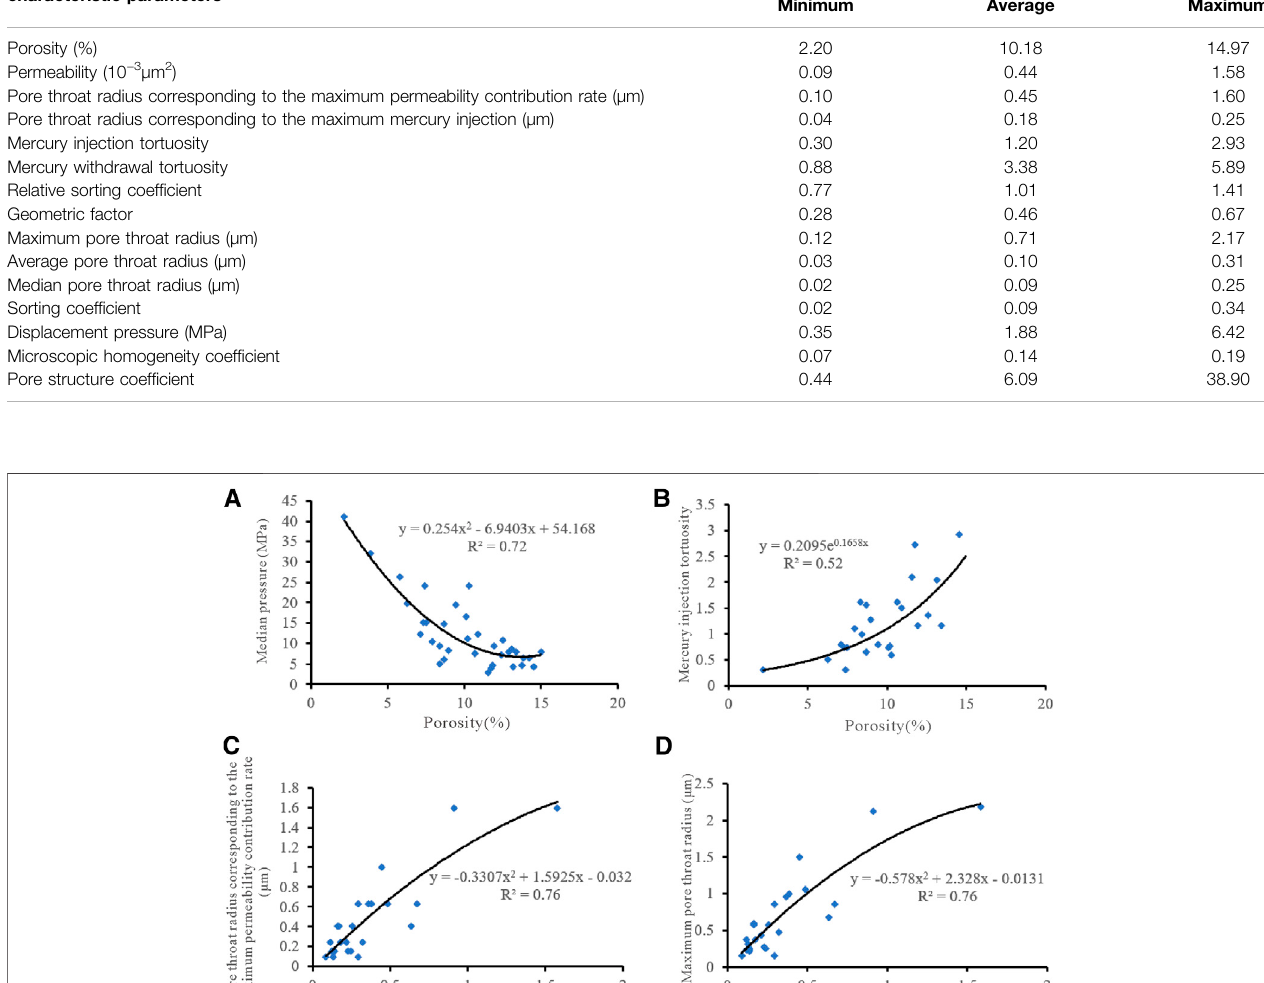
Frontiers in Earth Science |